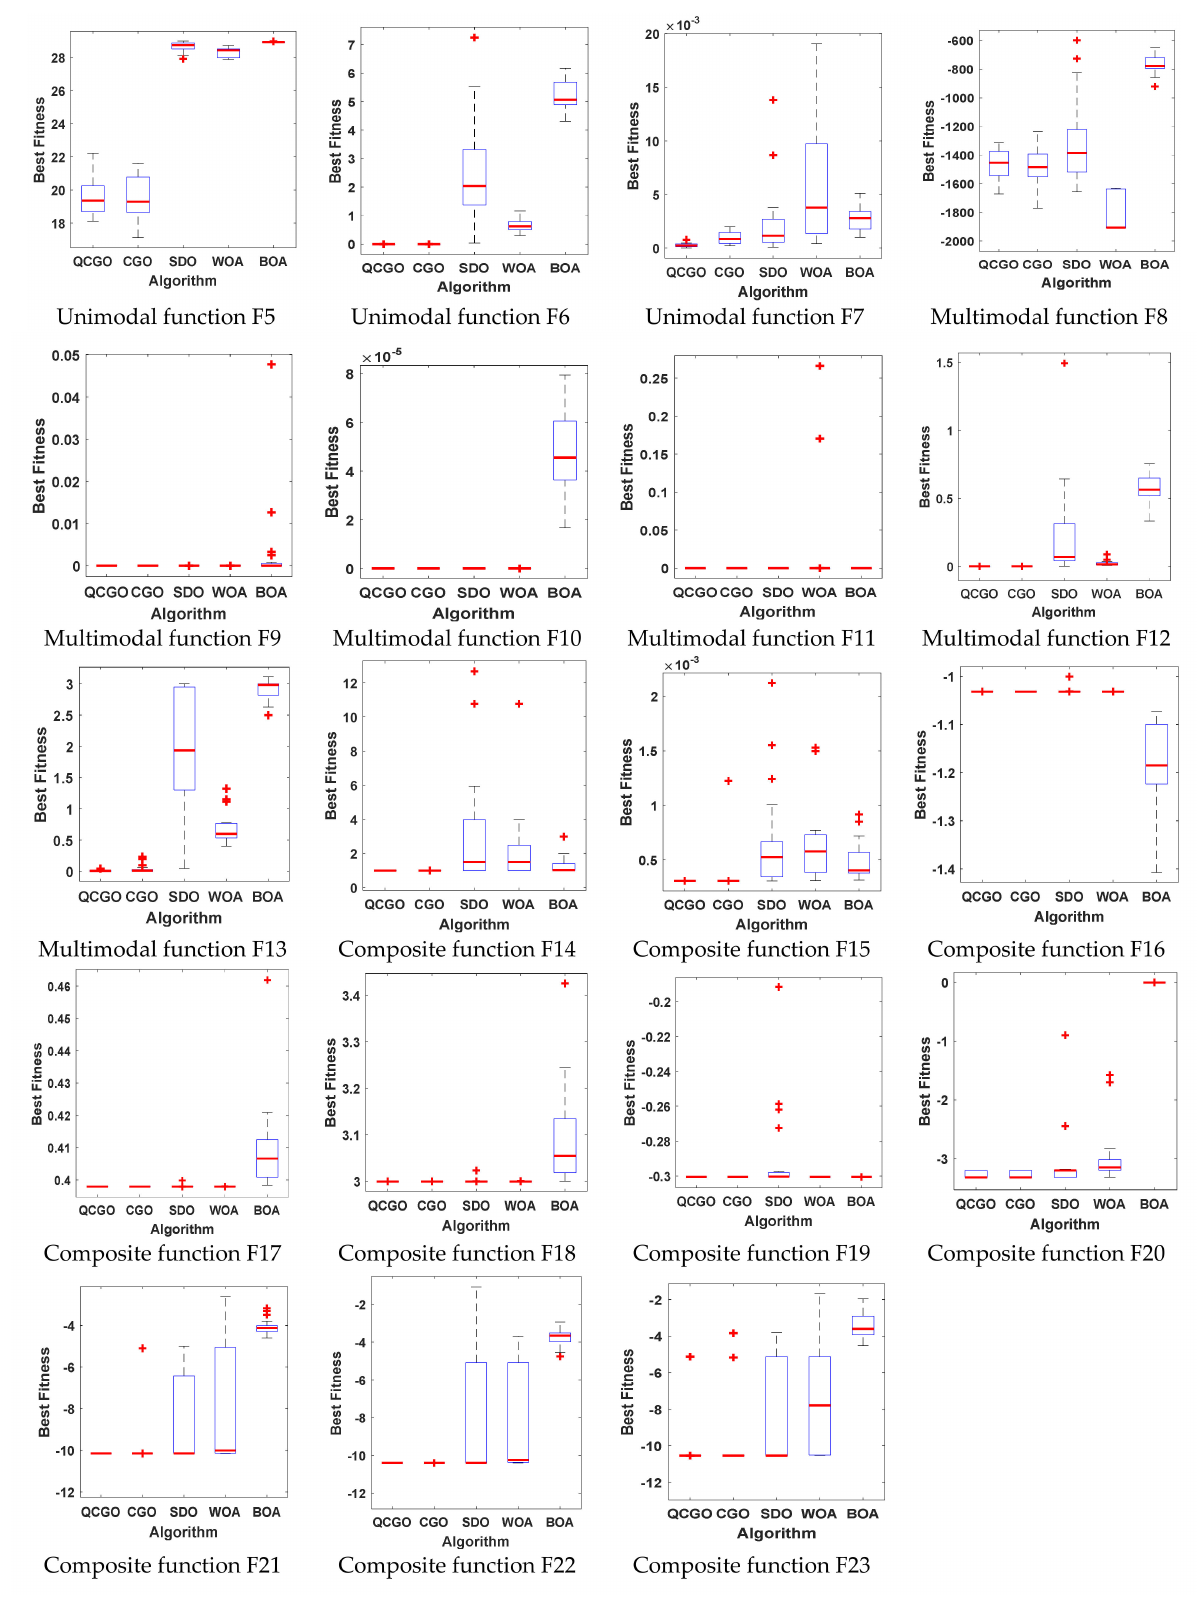
Figure 12. Boxplots of the proposed QCGO algorithm and four other algorithms for 23 bench- mark